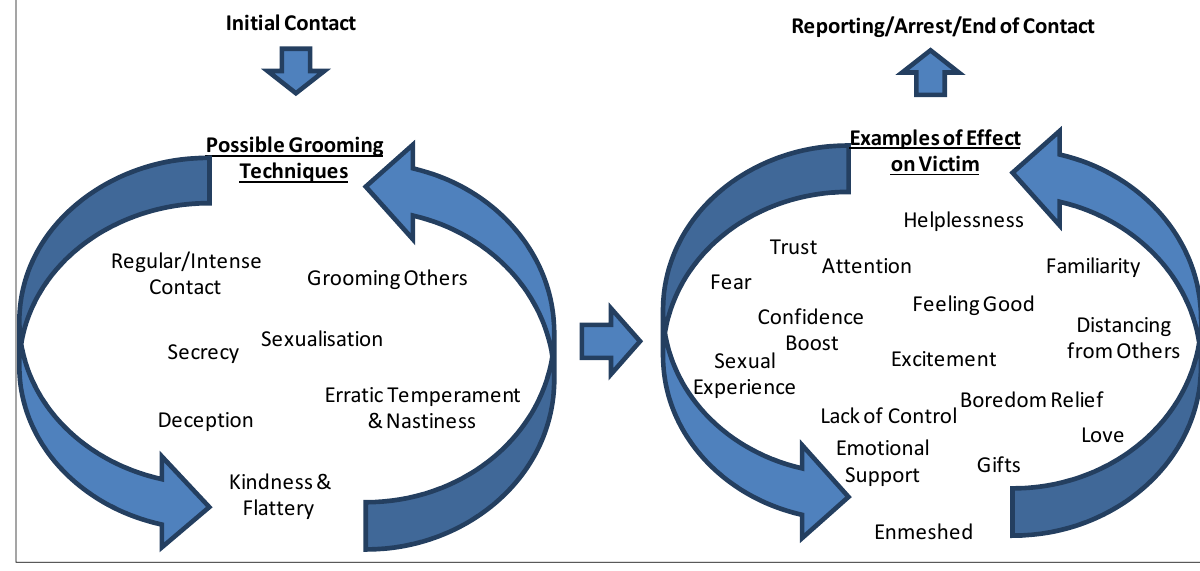
Figure 1. Summary of non-linear grooming techniques and effect on